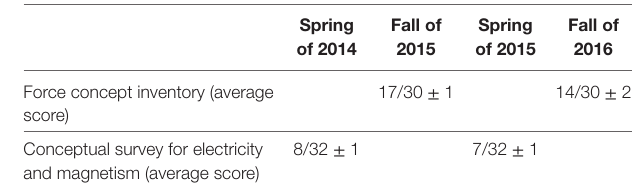
Table 2 | Comparison of pre-course conceptual physics survey results between the four semesters of students (S14/F15 when Perusall was not used compared to S15/F16 when Perusall was used).